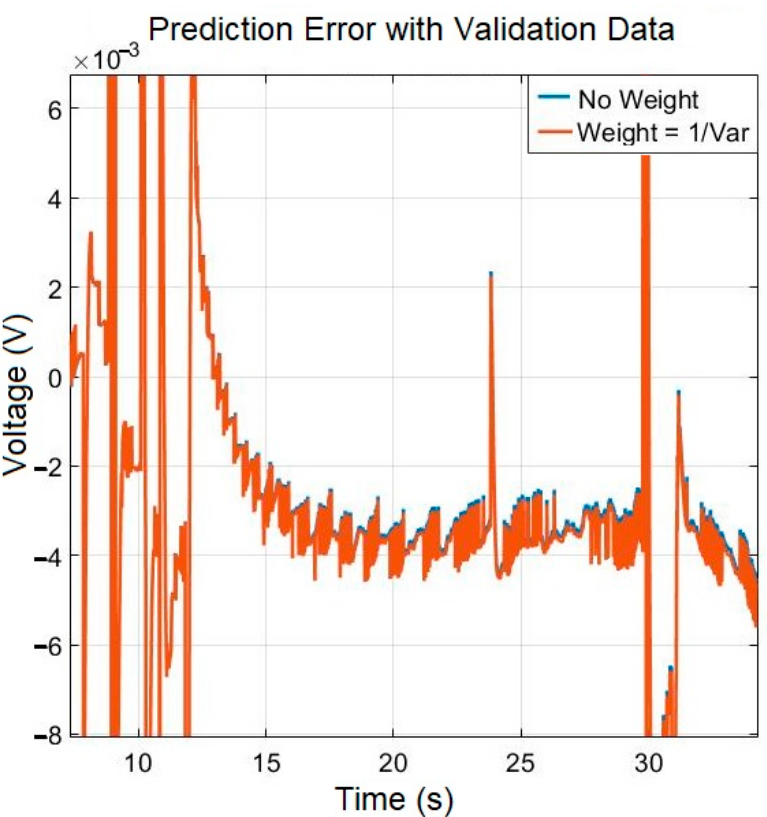
Figure 9. Prediction error regarding battery voltage—amplified signal. Table 5. Mean and RMS values of the prediction error (battery voltage) .